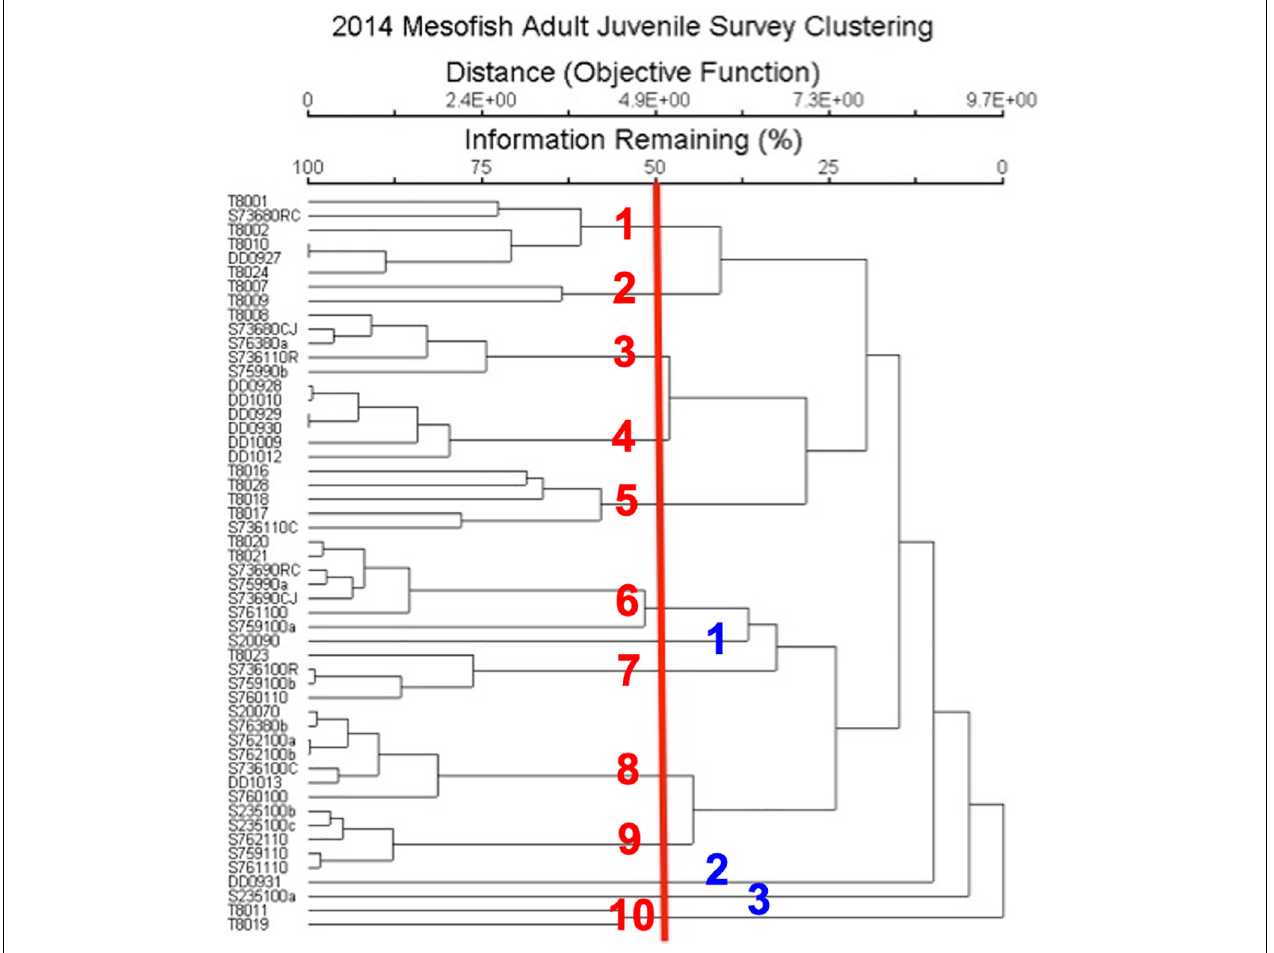
FIGURE 3 | Hierarchical clustering analysis of fish abundance by survey. Red line indicates the 50% explained variance cut-off from the NMDS, red numbers indicate the 10 clusters and blue numbers indicate surveys that were not part of a cluster. Survey by method (T, TOAD; S, Submersible; DD, Deep Diver) and date.